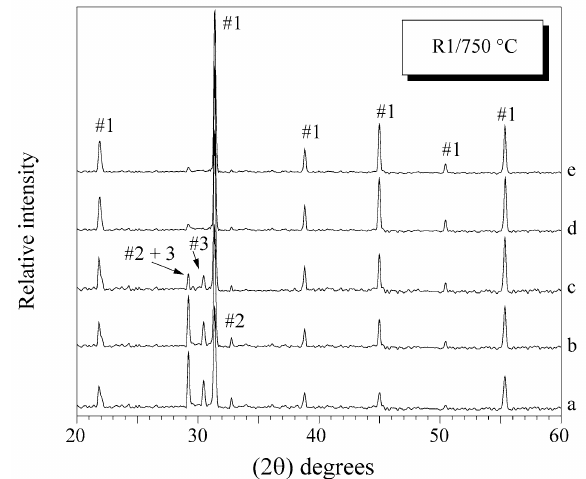
Figure 3. X-ray pattern for PMN powders prepared by route 1, calcined at 750 °C for: a) 1 h, b) 2 h, c) 3 h, d) 4 h, e) 5